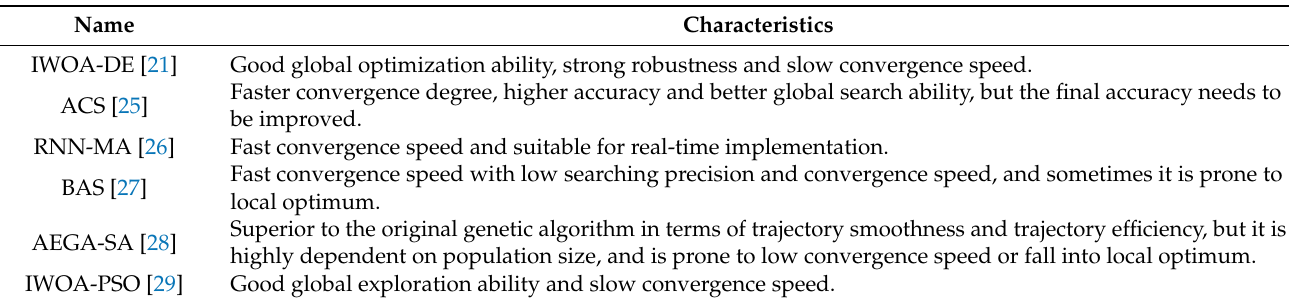
Table 1. Several optimization methods with their